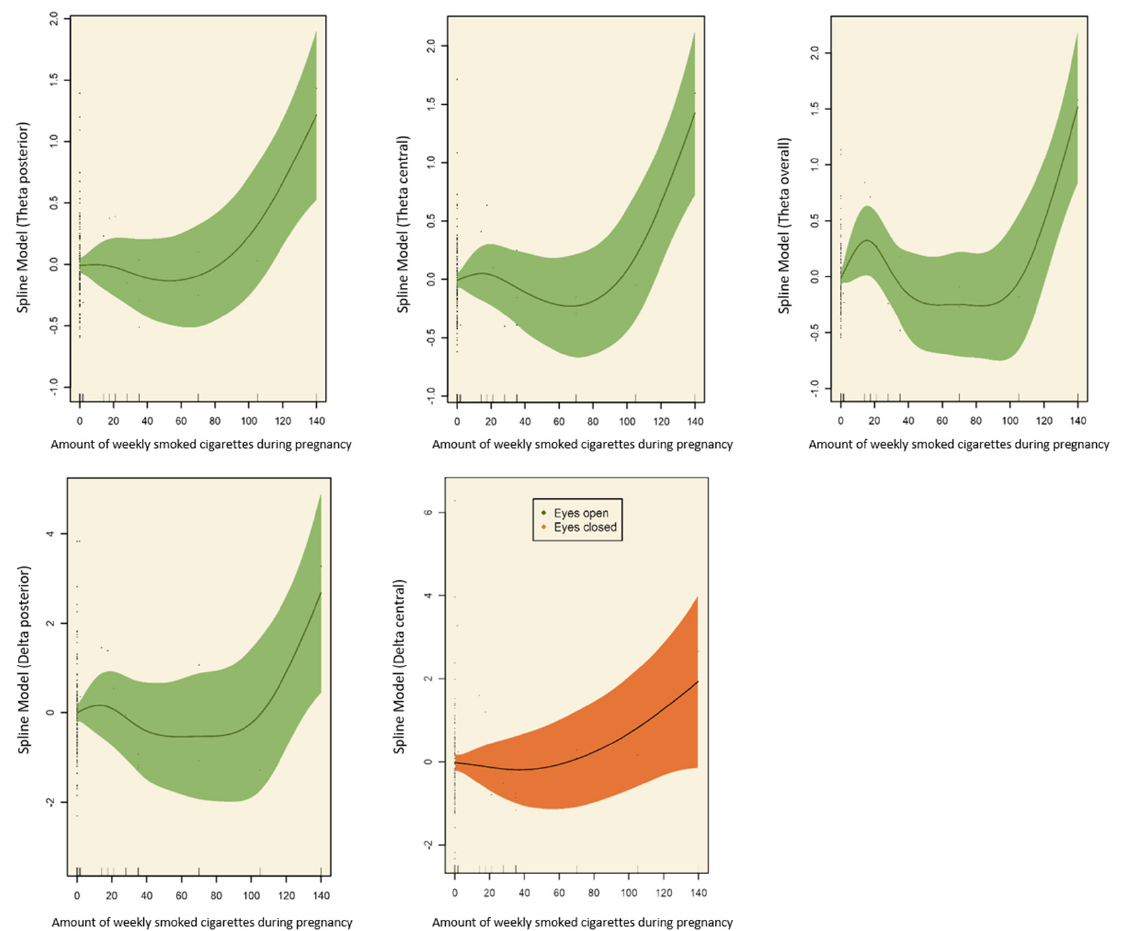
Figure 2. Spline models demonstrating a significant relationship between the estimated number of smoked cigarettes of the mother during pregnancy and offspring brain activity (delta and theta frequency bands), adjusted for covariates (child’s sex, child’s age, maternal age, maternal psychopathology, maternal smoking before pregnancy, maternal alcohol drinking, week of pregnancy at birth).